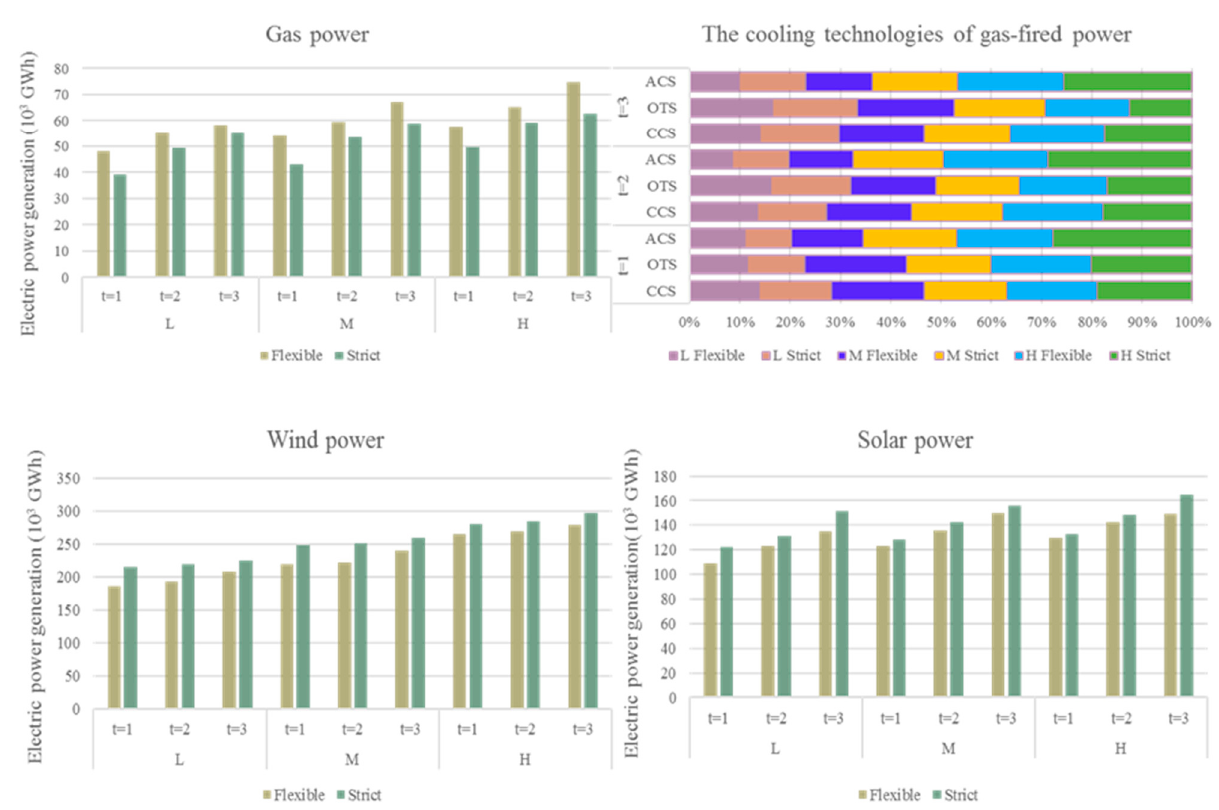
Figure 6. The optimized electric power generation and capture and storage technology (CCS) scheme (ACS, OTS, and CCS denote the air-cooling system, the one-through system, and the cycling cooling system, respectively).